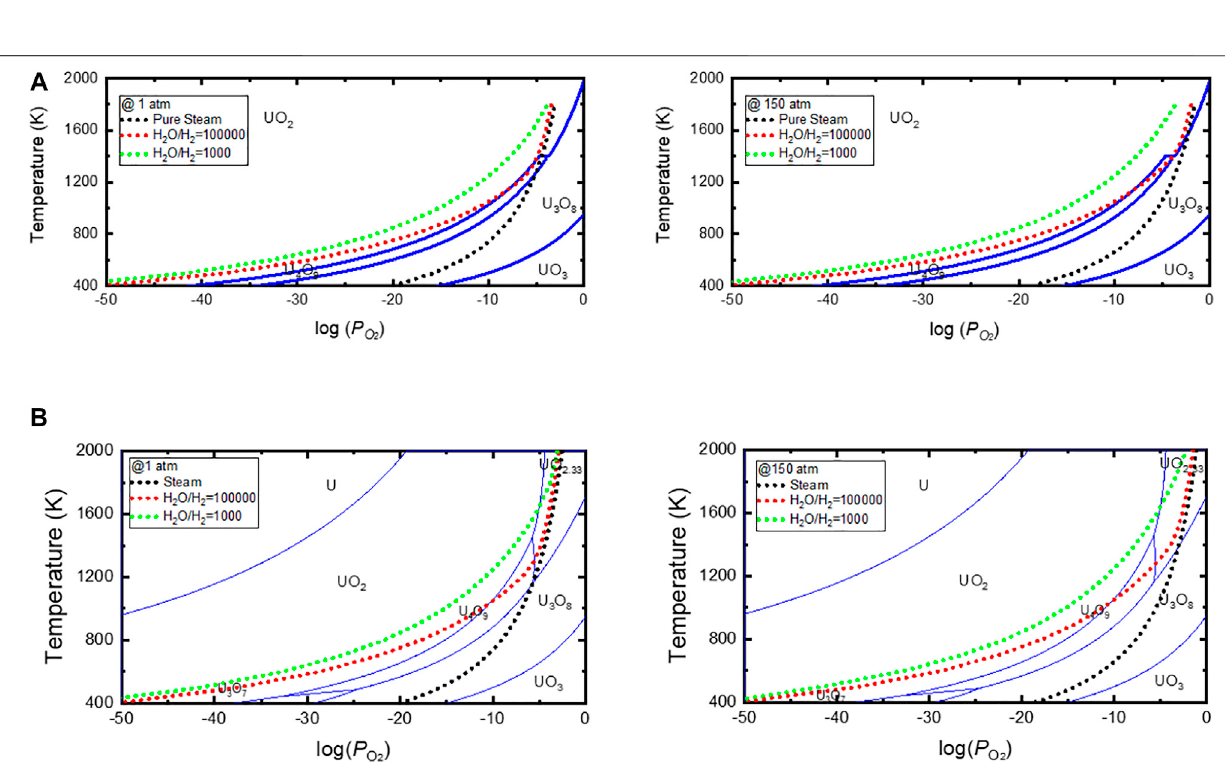
Frontiers in Energy Research |